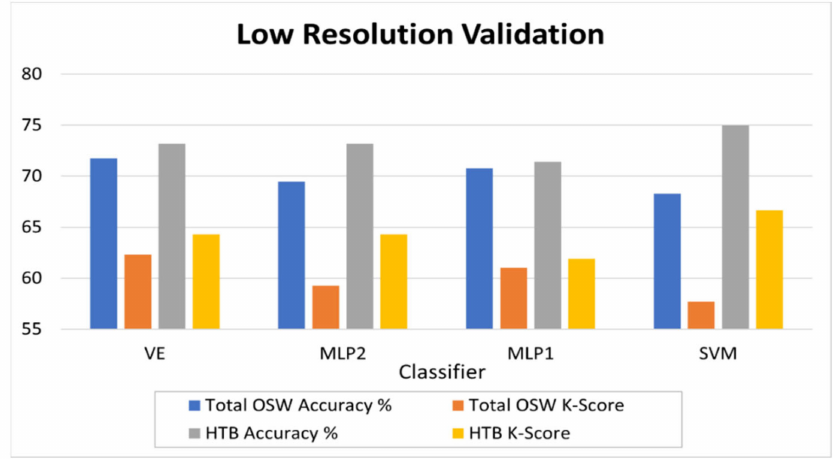
Figure 5. Accuracy and K-scores for each classifier for the OSW and HTB